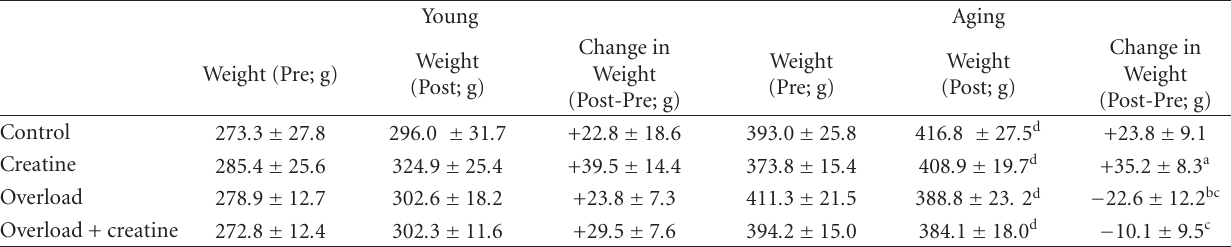
Table 2: Pre- and posttreatment weight of young and aging animals.